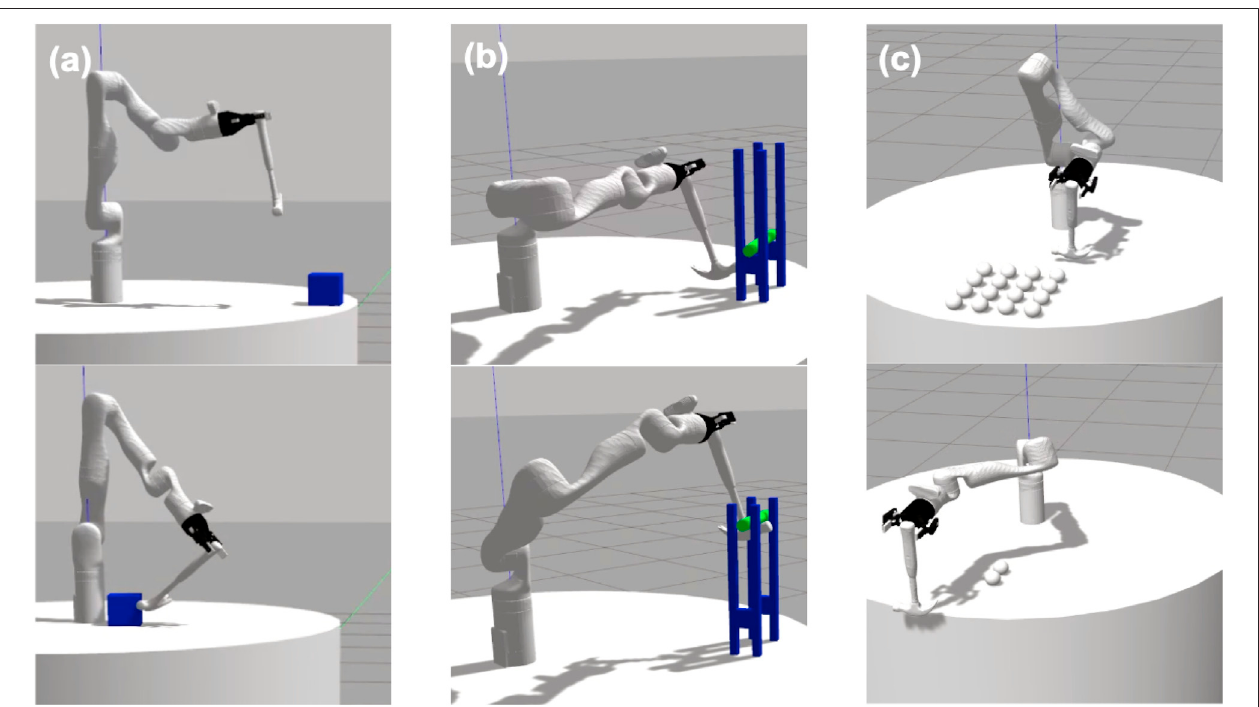
FIGURE 3 | Initial and goal states for the (A) hooking, (B) lifting, and (C) sweeping tasks.